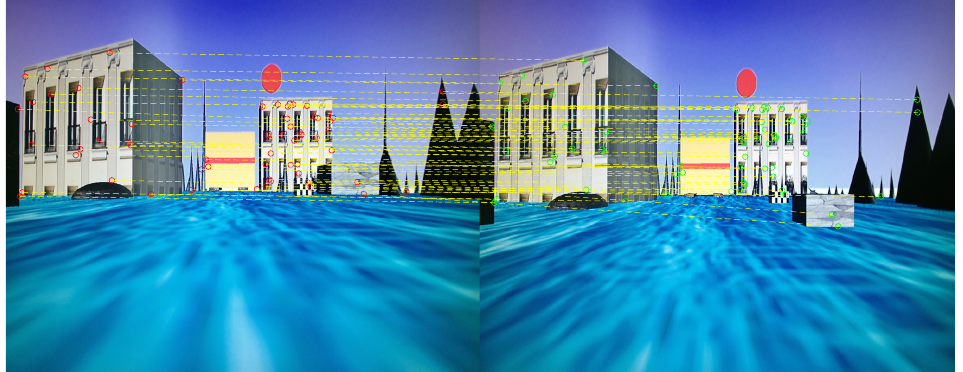
Figure 6. Feature detection and